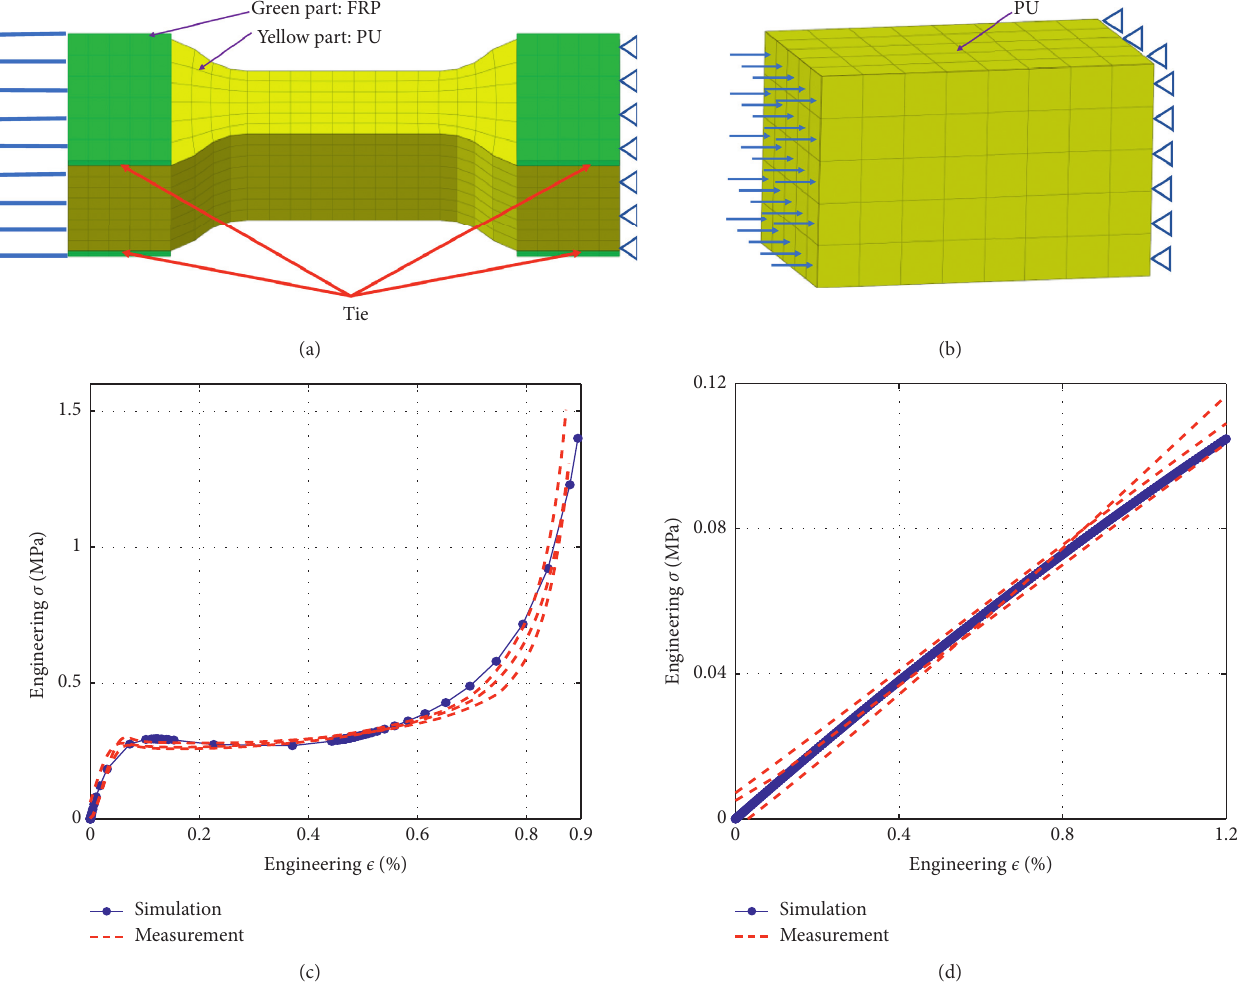
Figure 5: FEA models of the polyurethane foam for uniaxial (a) compression and (b) tension and measured and simulated σ - ε curves for uniaxial (c) compression and (d) tension.